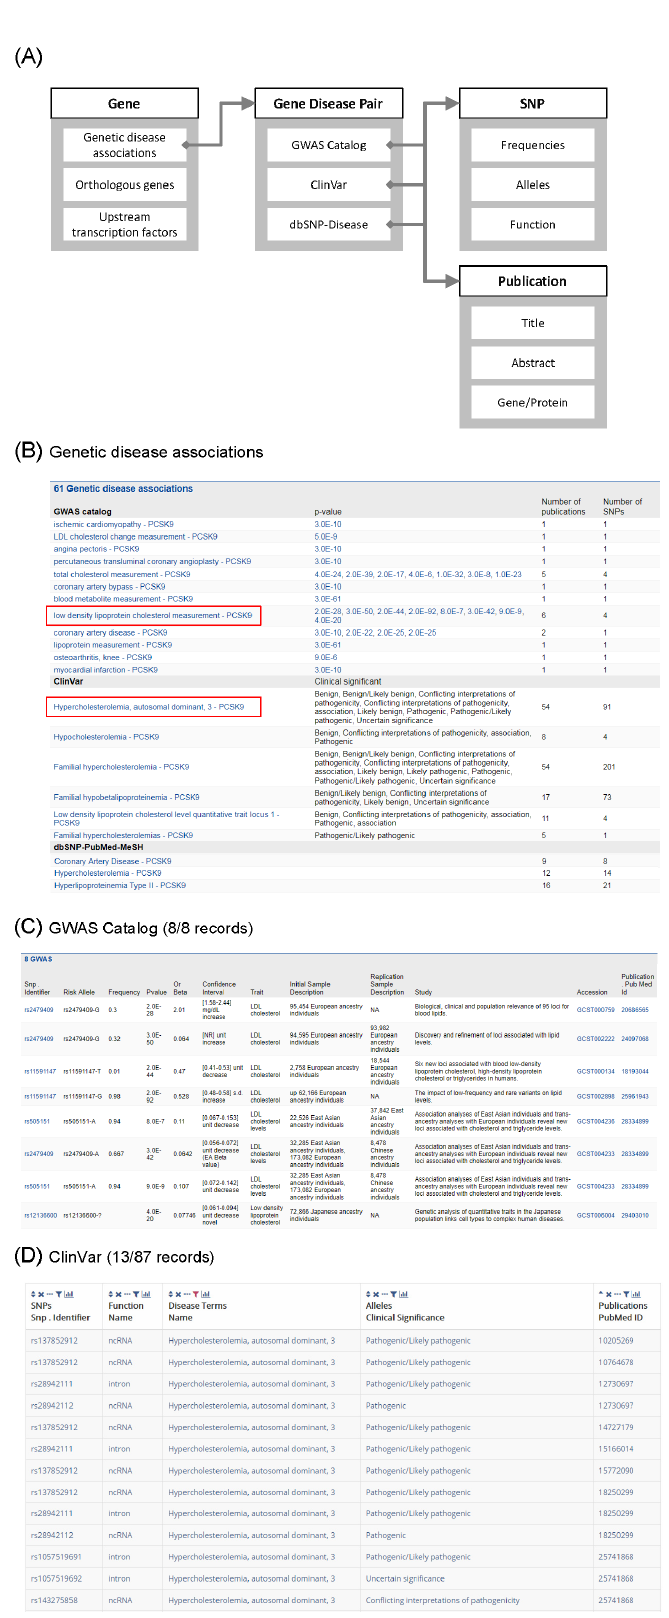
Figure 3. Searching information about linkage to disease with TargetMine. ( A ) Outline of the procedure for searching. ( B ) A screenshot of the summary of Genetic disease associations of PCSK9. ( C ) GWAS records of a pair of PCSK9 and low density lipoprotein cholesterol measurement. ( D ) ClinVar records of a pair of PCSK9 and hypercholesterolemia, autosomal dominant, 3.